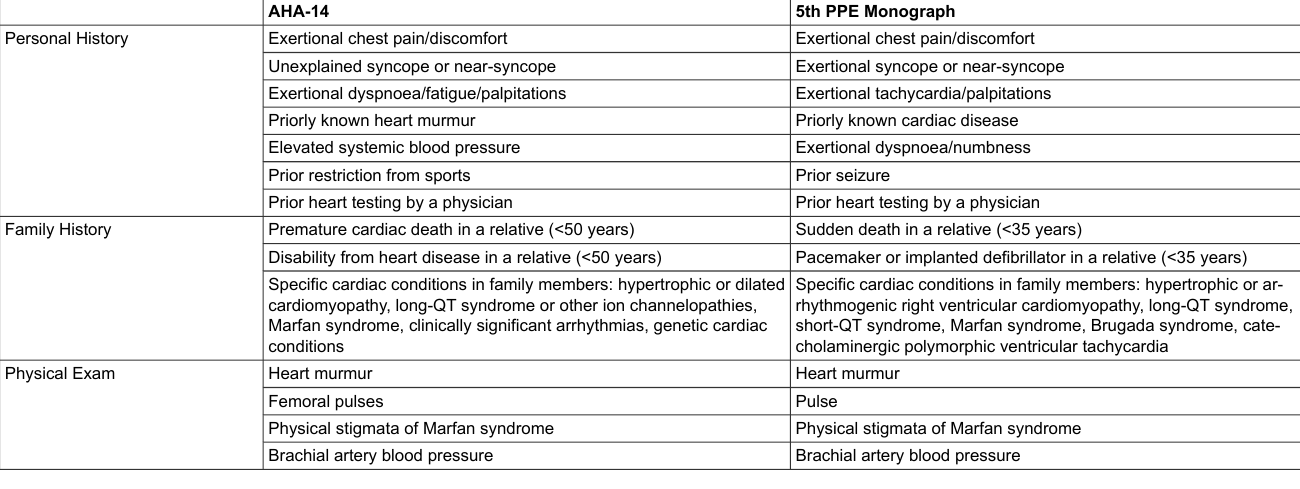
Table 2: Comprehensive evaluation by medical history and physical examination according to the American Heart Association 14-Element Screening (AHA-14) [28] or the American Academy of Pediatrics 5 th PPE Monograph (5 th PPE Monograph) [29]. AHA-14